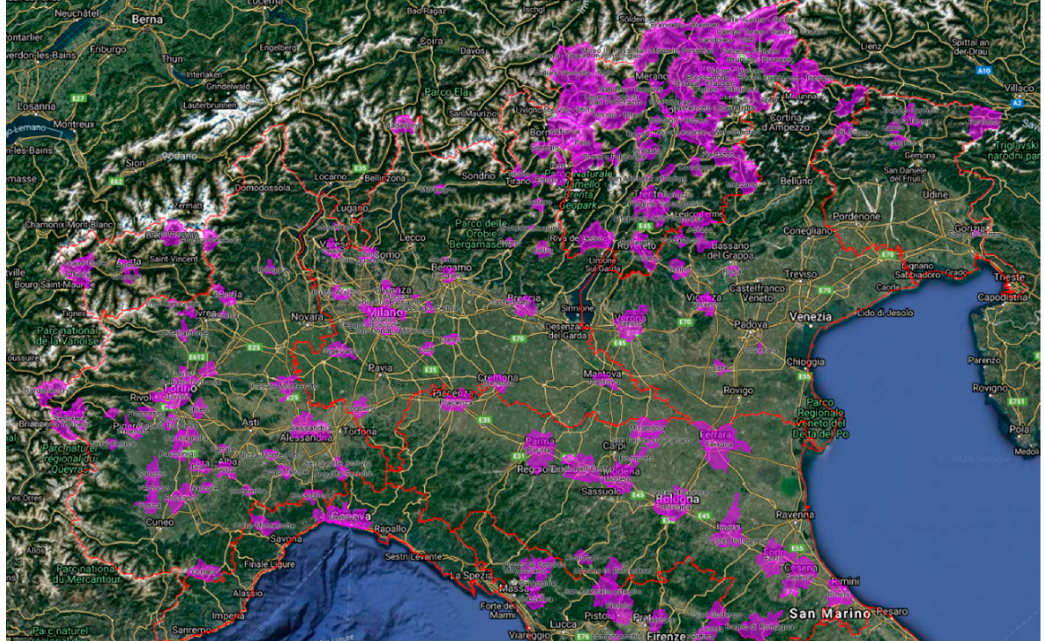
Figure 4. Map with the location of plants for electrical production from solid biomass in northern Italy (Source: GSE Atlaimpianti [57]).